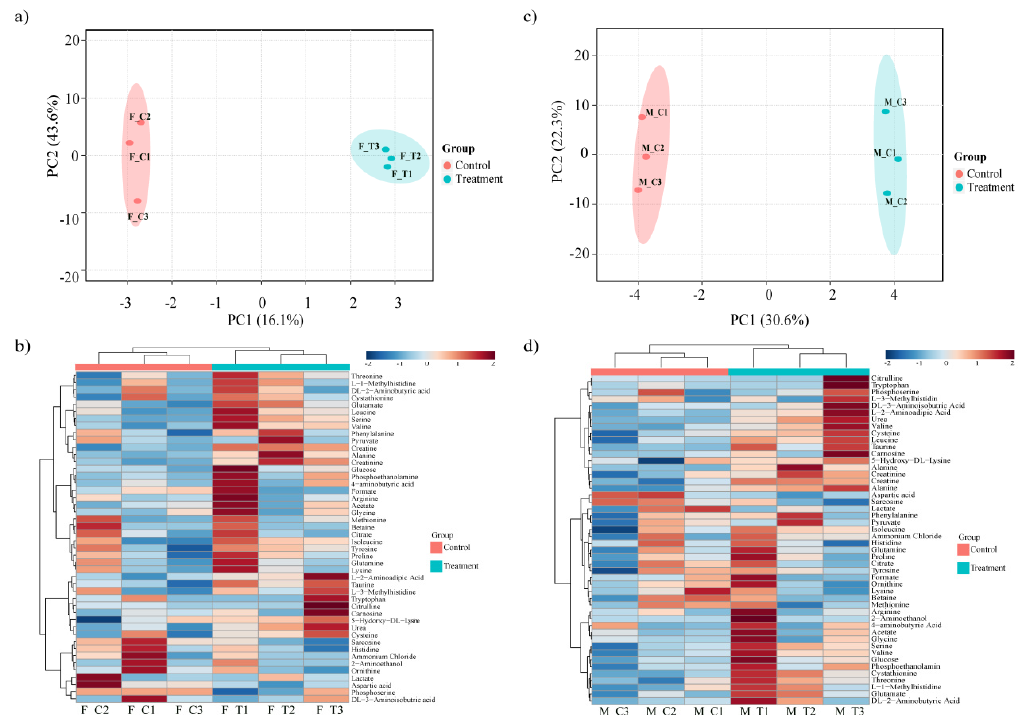
Figure 5. Metabolome analysis: ( a ) metabolic profiles of the female group visualized with principal component analysis; ( b ) heat map of all metabolites identified in the female group; ( c ) metabolic profiles of the male group visualized with principal component analysis; ( d ) heat map of all metabolites identified in the male group.